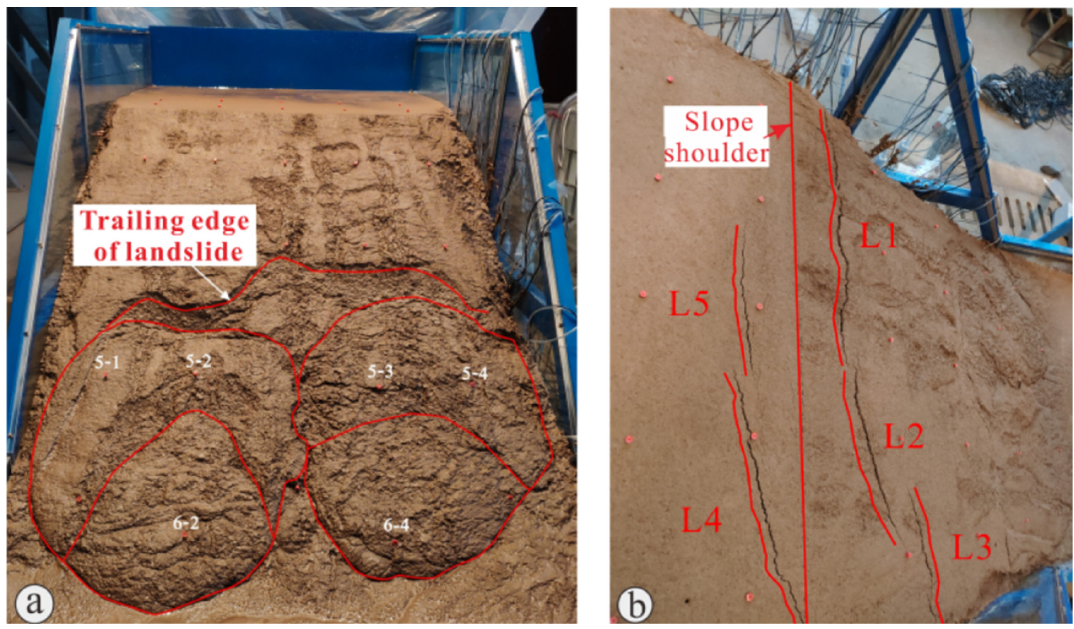
Figure 13. Large-scale shallow sliding failures. ( a ) Shallow sliding of slope toe, and ( b ) slope top and surface cracks.